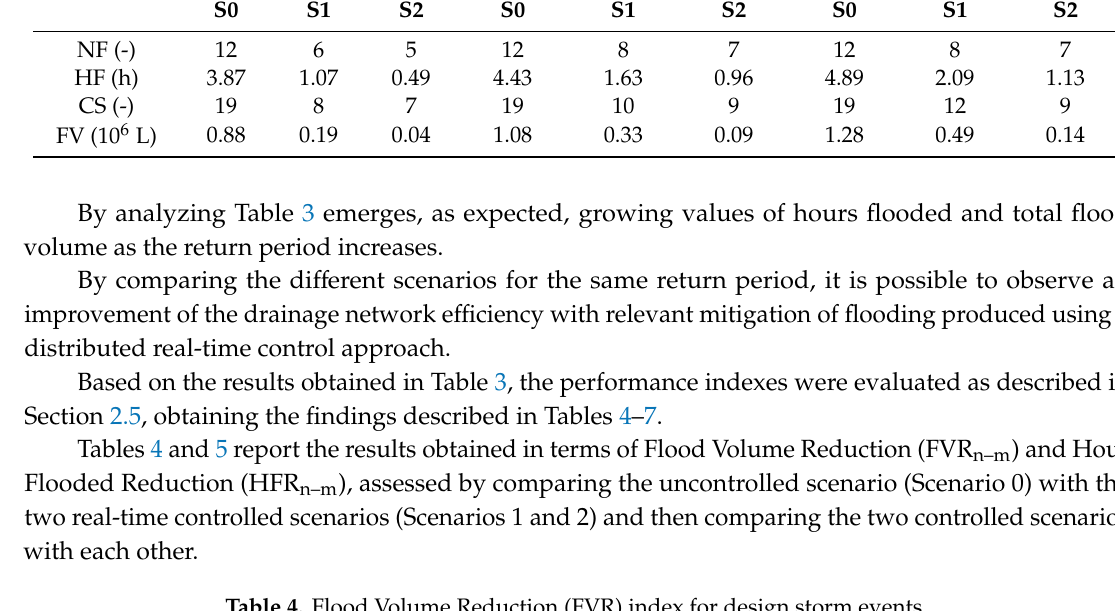
Table 4. Flood Volume Reduction (FVR) index for design storm events.